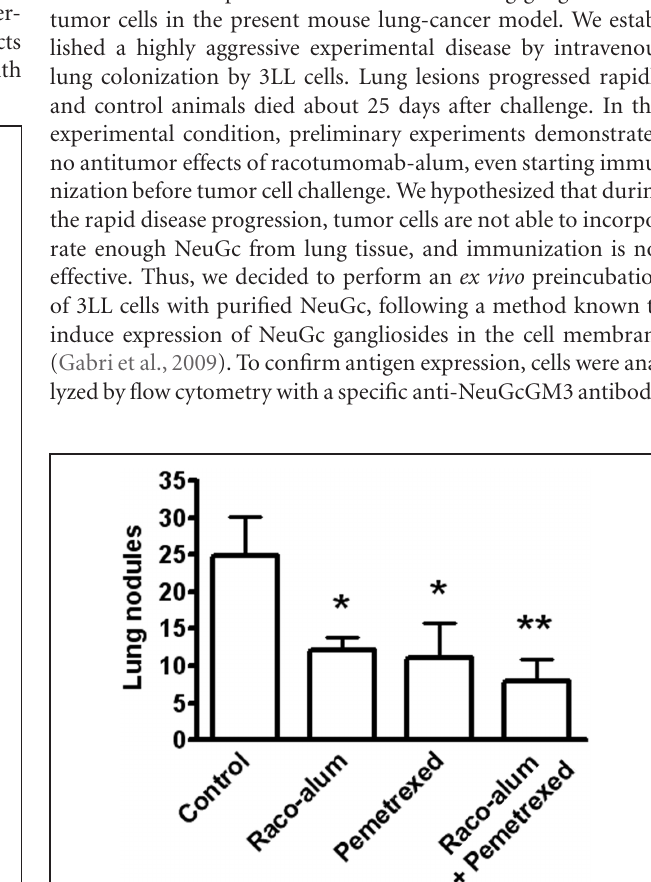
FIGURE 1 | Antitumor protection against spontaneous lung nodule formation by immunization with racotumomab-alum. Mice were inoculated subcutaneously with 3LL cells and immunized with racotumomab-alum at a dose of 50 μ g, as described in “Materials and Methods.” (A) Subcutaneous primary tumor growth. Data represent mean ± SEM. No significant effects were detected between control and treated animals. (B) Spontaneous lung tumor nodules. Immunization significantly reduced the number of lung nodules compared to control. Data points represent individual mice and horizontal lines indicate the median values. Data were pooled from two independent experiments with similar results. ∗ p = 0 . 0377 (unpaired t -test with Welch’s correction).